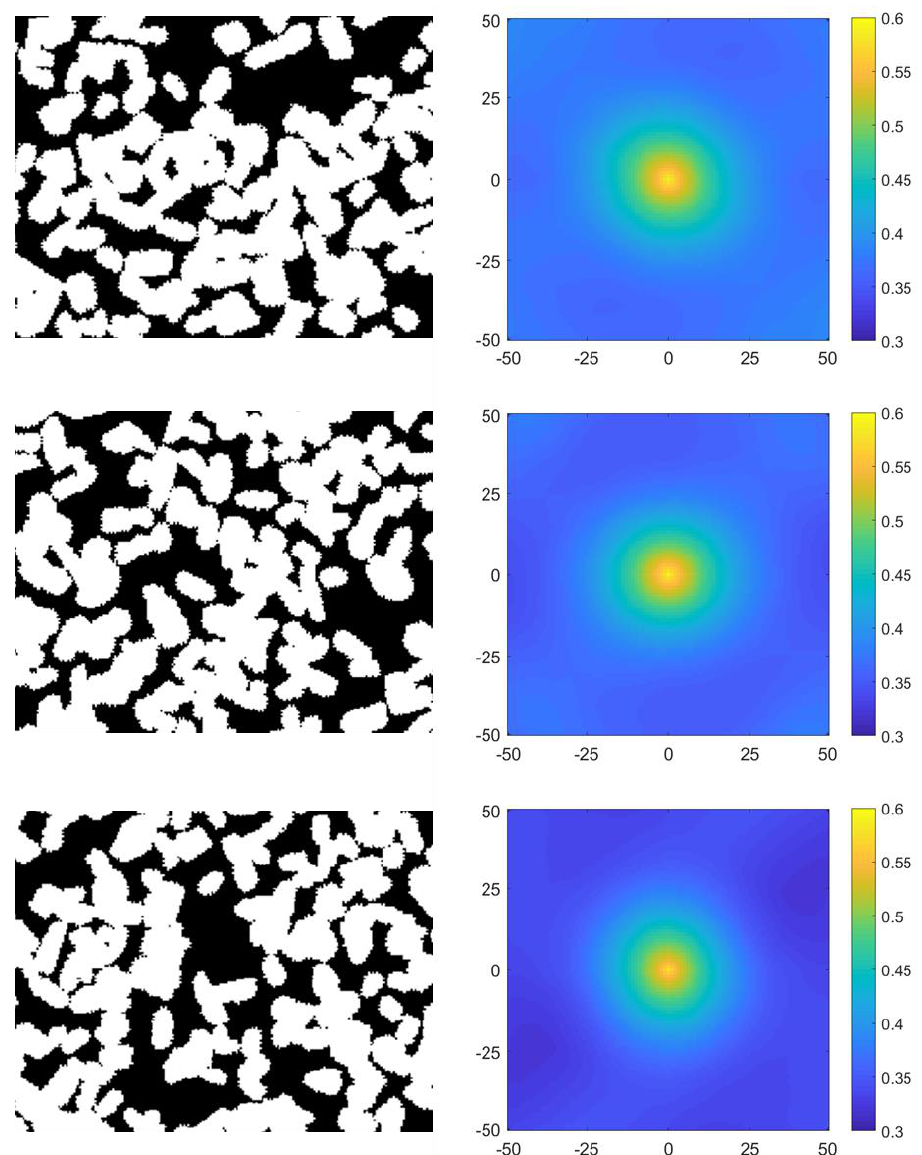
Figure 14. Three examples of microstructures generated using the mined object library using statistical cost functions.